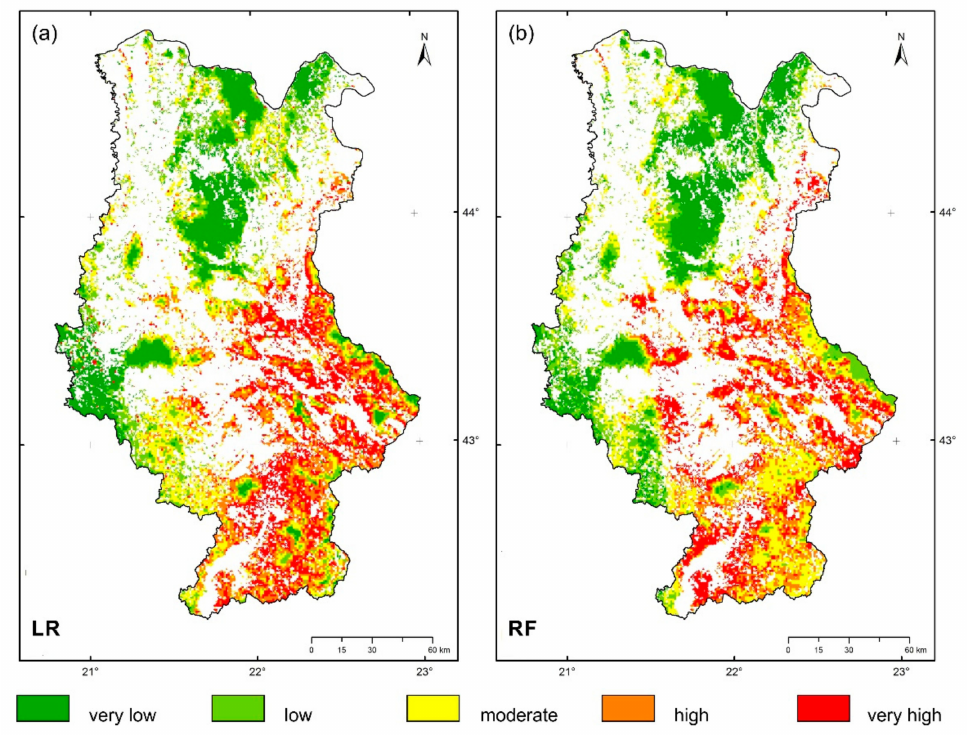
Figure 5. Maps of forest fire probability based on ( a ) LR models, ( b ) RF